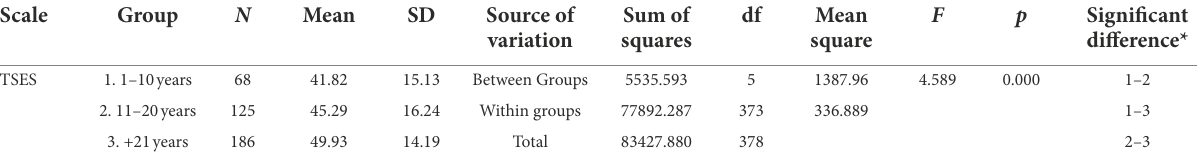
TABLE 5 “ANOVA test” results for “TSES” in regard to